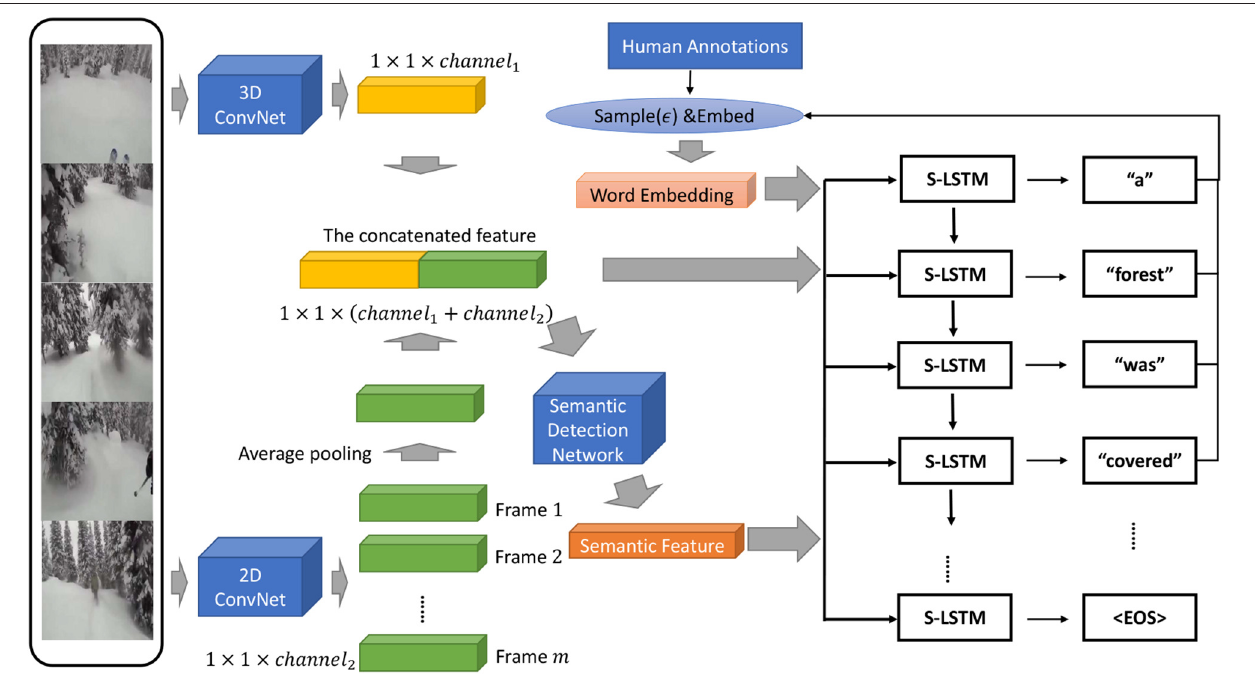
FIGURE 2 | Overall framework of our model. A 3D ConvNet, a 2D ConvNet and a Semantic Detection Net (SDN) constitute the encoder component of our model. S-LSTM stands for a semantics-assisted variant of LSTM which takes a semantic feature, a visual feature and a word embedding as inputs at each step. The word fed as the input to the decoder is sampled from human annotations or the model itself randomly, and then is embeded with the pretrained